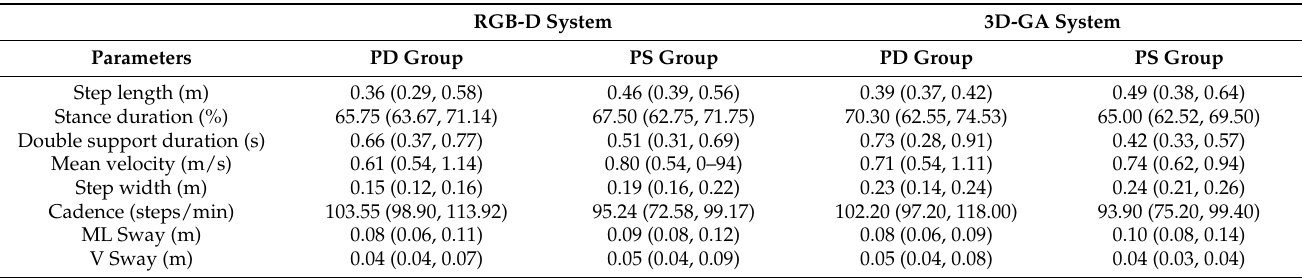
Table 3. Median (first and third quartile) values for spatio-temporal and COM parameters estimated for the two systems of the PD and PS